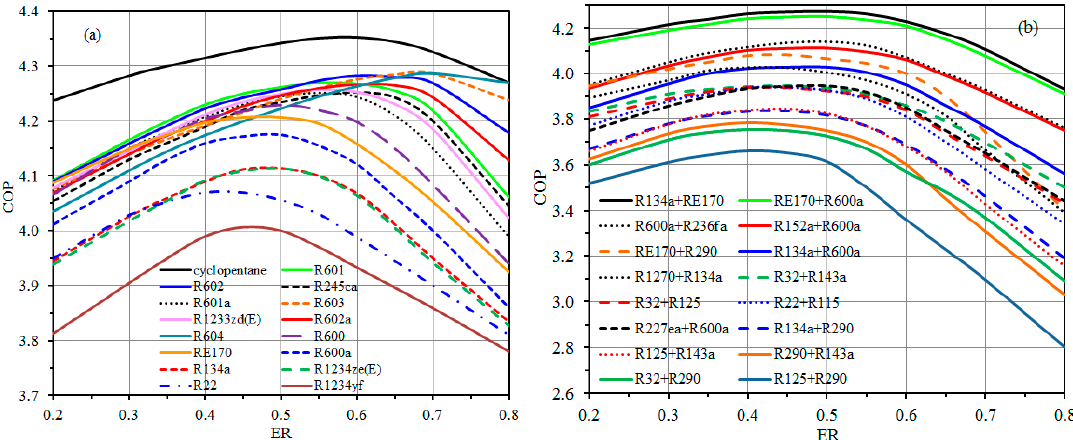
Figure 7. Effect of ER on COP of the TSVCRC using; pure refrigerants ( a ), and mixed refrigerants ( b ).